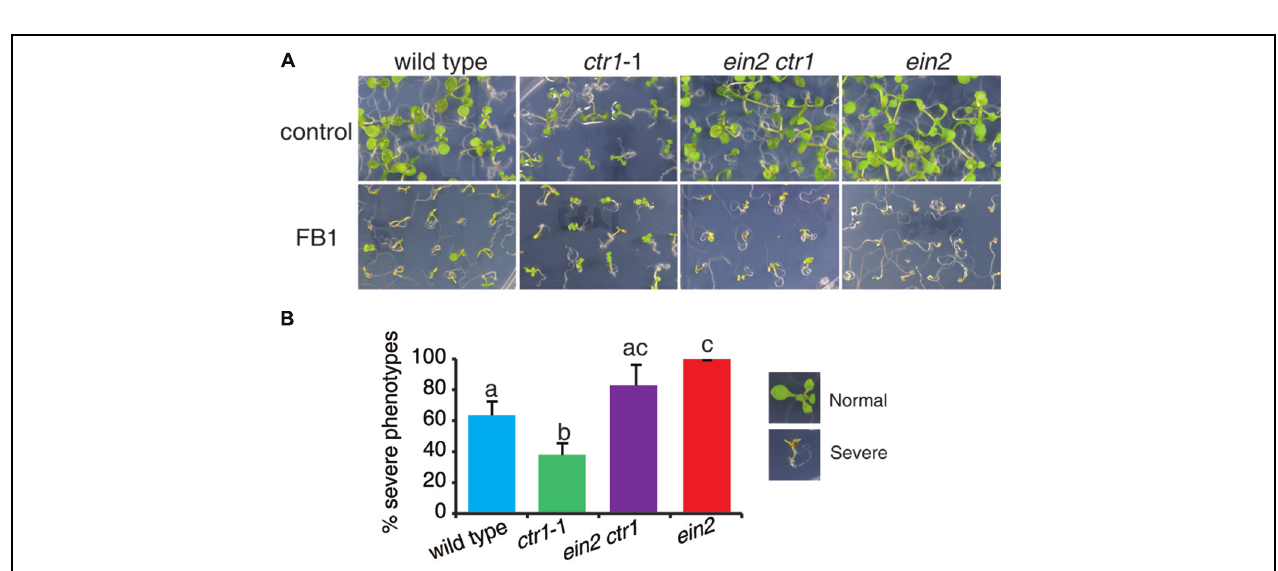
FIGURE 2 | Phenotypes of FB1-treated wild-type, ctr1 -1, ein2 ctr1 -1, and ein2 plants. (A) The wild-type, ctr1 -1, ein2 ctr1 -1, and ein2 seeds were germinated on 1/2x MS with or without 0.5 µ M FB1. Photos were taken after 8 days of treatment. (B) Quantitation of the phenotypes in (A) . Seedlings with cotyledon bleaching were scored as having a severe phenotype. The data represent means of three independent experiments. At least 40 seeds of each sample were used in each experiment. Data are means ± SD ( n = 3) and sets marked with different letters indicate significances assessed by Student–Newman–Keul test ( P < 0.05).